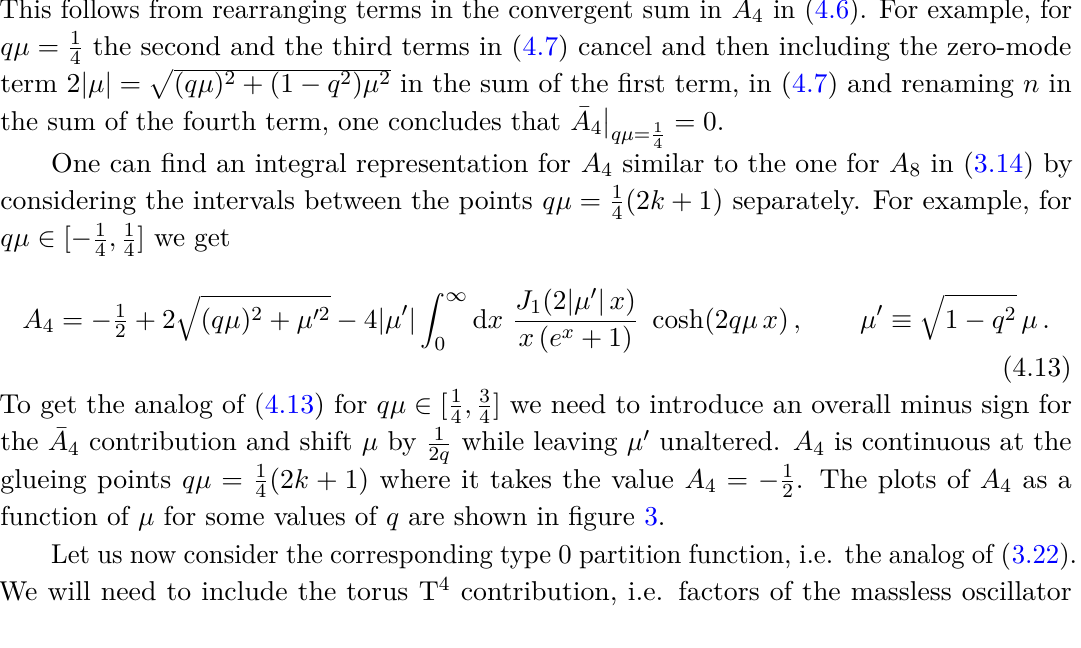
for qµ = 1 k + 1 , k ∈ Z 2 2 4